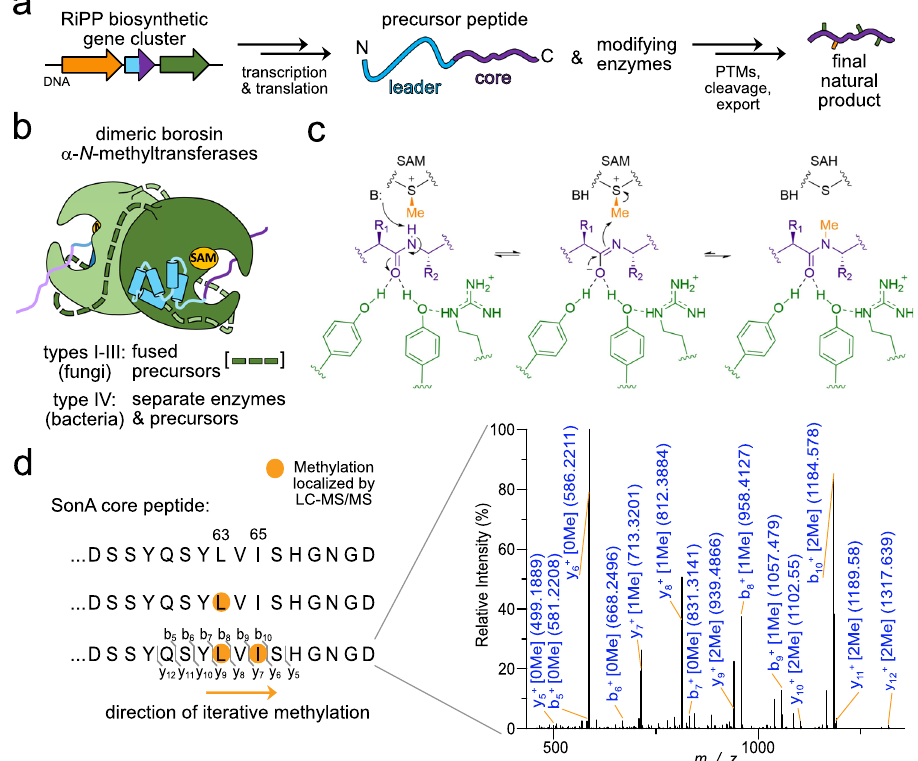
Fig. 1 Borosin RiPP biosynthesis. Reaction schemes and protein structure con fi gurations for the biosynthesis of borosin RiPP metabolites. a General scheme for RiPP biosynthesis highlighting the typical composition of precursor peptides. b Dimeric protein architectures of borosin α - N - methyltransferases. Types I – III borosin pathways 24 encode α - N -methyltransferases that are fused (dashed segments) to their precursor